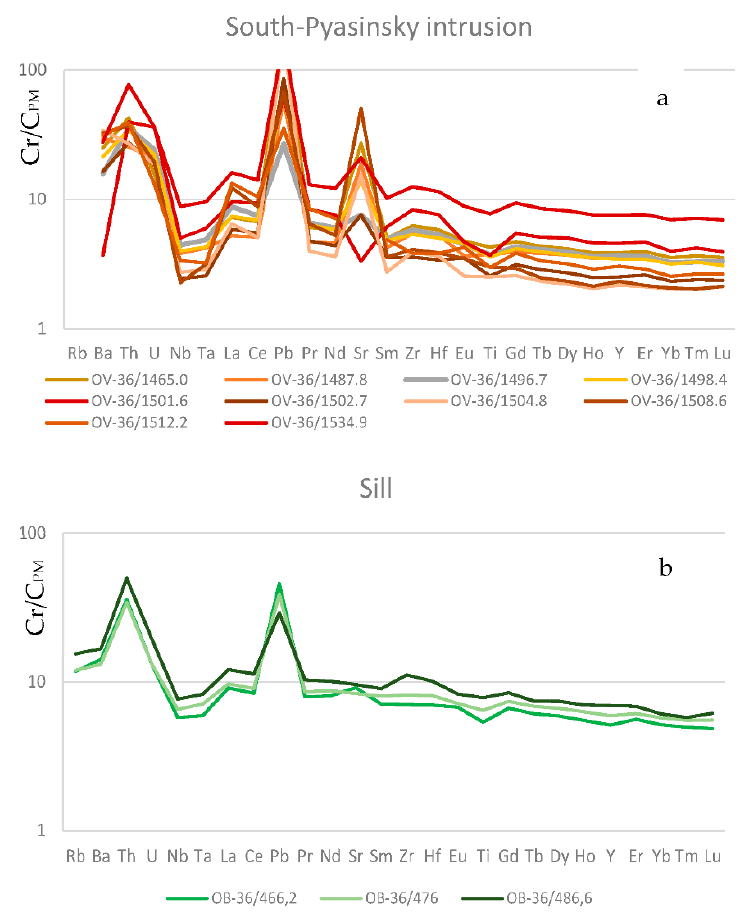
Figure 17. Spider-diagrams for the intrusive rocks in the Vologochan syncline: ( a ) South Pyasinsky intrusion, ( b ) sill.